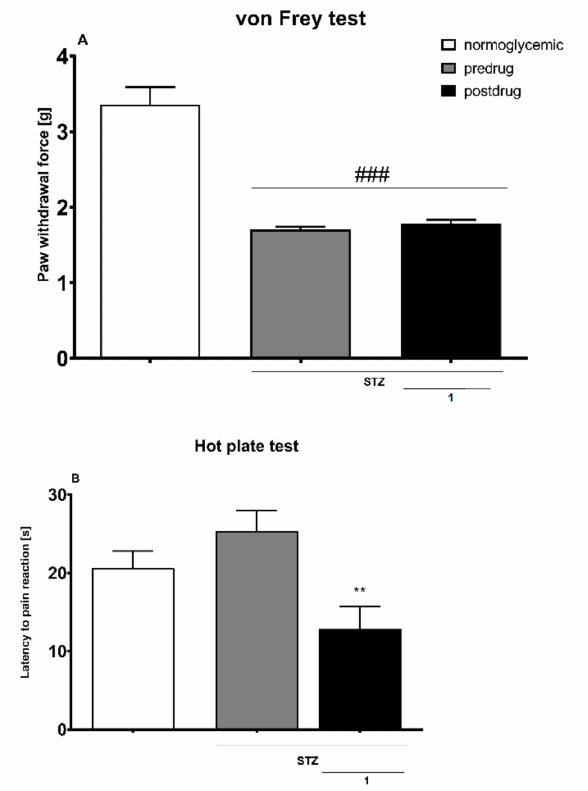
Figure 6. Assessment of antiallodynic activity of the compound 1 (30 mg/kg i.p.) in the diabetic neuropathic pain model measured using the von Frey test ( A ), and antihyperalgesic effect of this compound assessed in diabetic mice and measured using the hot plate test ( B ). Results are shown as the mean ( ± SEM) force applied to elicit paw withdrawal ( A ), or the mean ( ± SEM) latency to pain reaction ( B ). Statistical analysis: repeated measures ANOVA, followed by Tukey’s post hoc comparison. Significance vs. normoglycemic control: ### p < 0.001, and vs. pre-drug value in the individual group: ** p < 0.01. In the vehicle-treated normoglycemic mice measurements of pain sensitivity threshold were taken in the same manner as in the STZ group, but vehicle-treated mice were not treated with